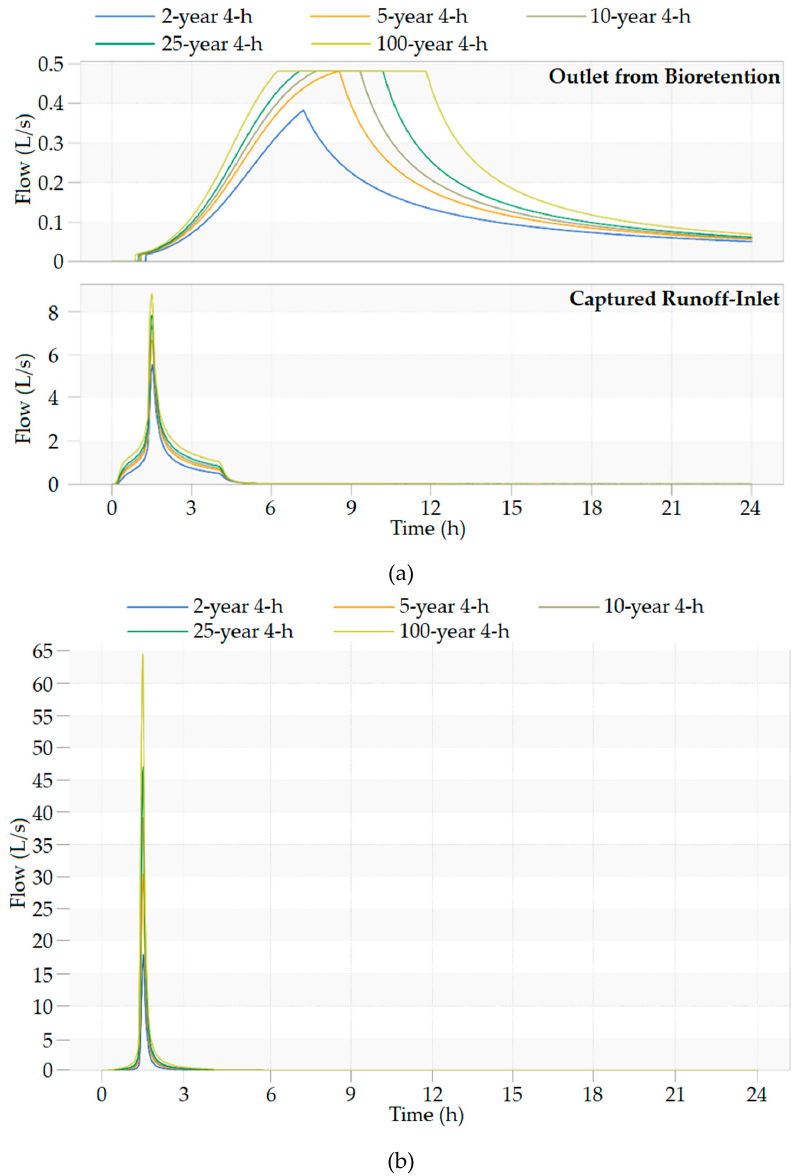
Figure 10. Hydrographs of a single and twin grid catch basin ( a ) inlet and outlet hydrographs; and ( b ) bypassed hydrographs.